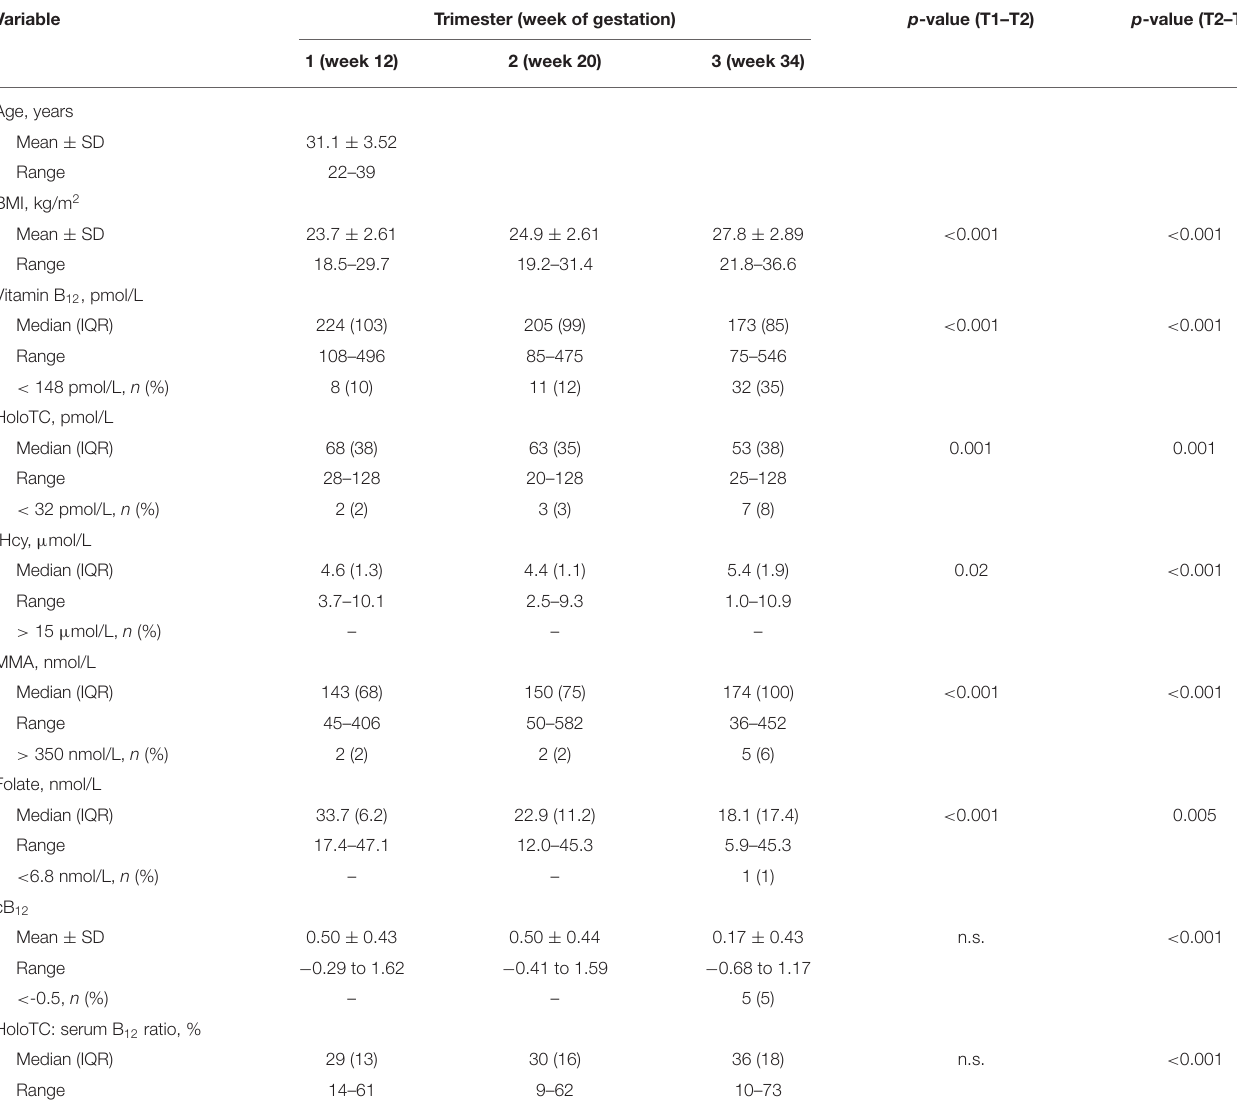
TABLE 1 | Characteristics of the study population a .